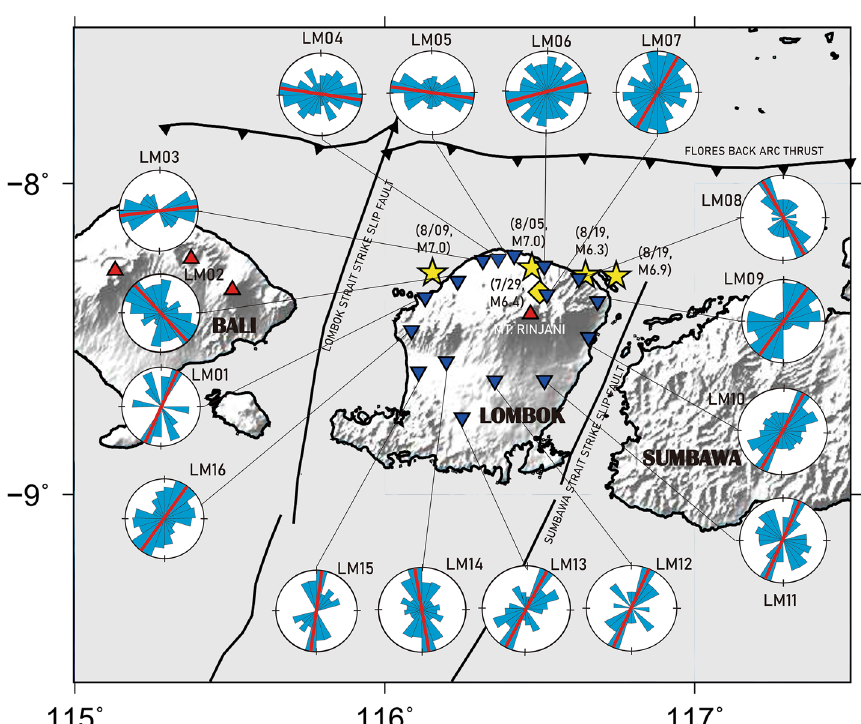
Fig. 3 Rosette diagram distribution of ф direction parameter in each seismographic station, shown by circles with blue bars. The radius of the rosette diagram shows the number of ф recorded at each seismic station. The red lines show the average value of ф . The yellow stars represent the epicenter of significant earthquakes (Sasmi et al. 2020), and the yellow diamond shows the epicenter of M 6.4 July 29, 2018 earthquake (BMKG, 2019). The blue inverted triangles indicate the distribution of seismographic